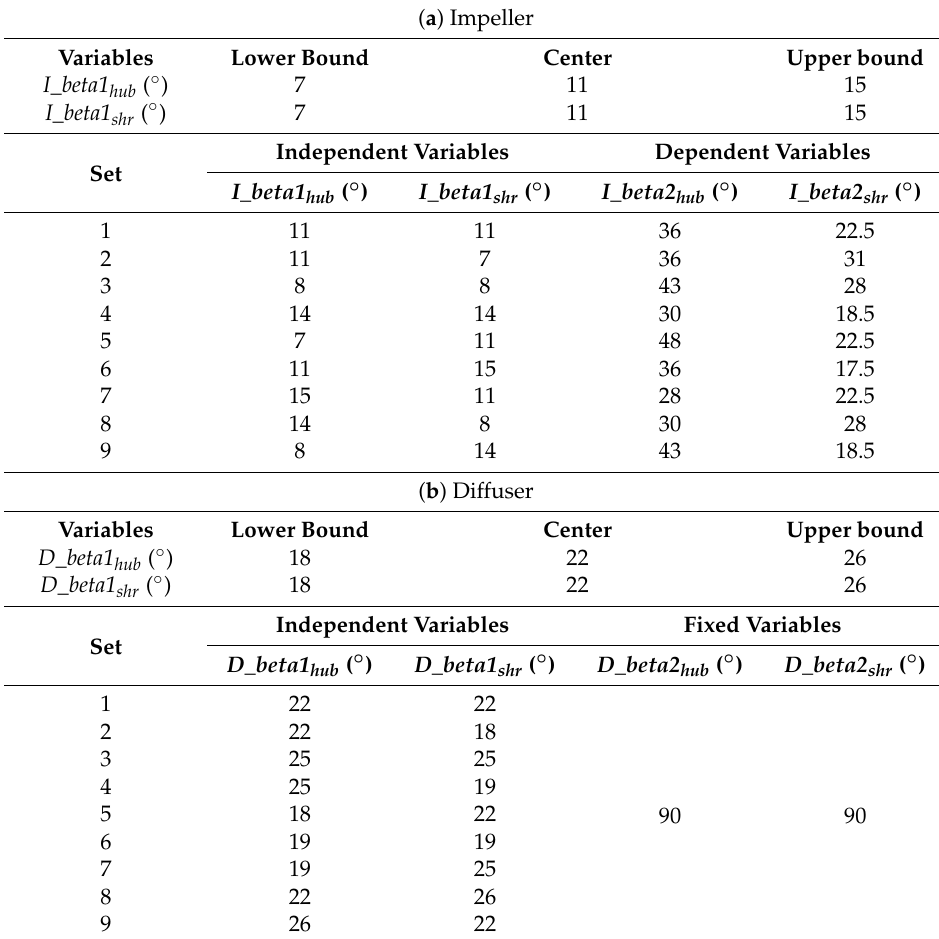
Table 3. Feasible design ranges and training